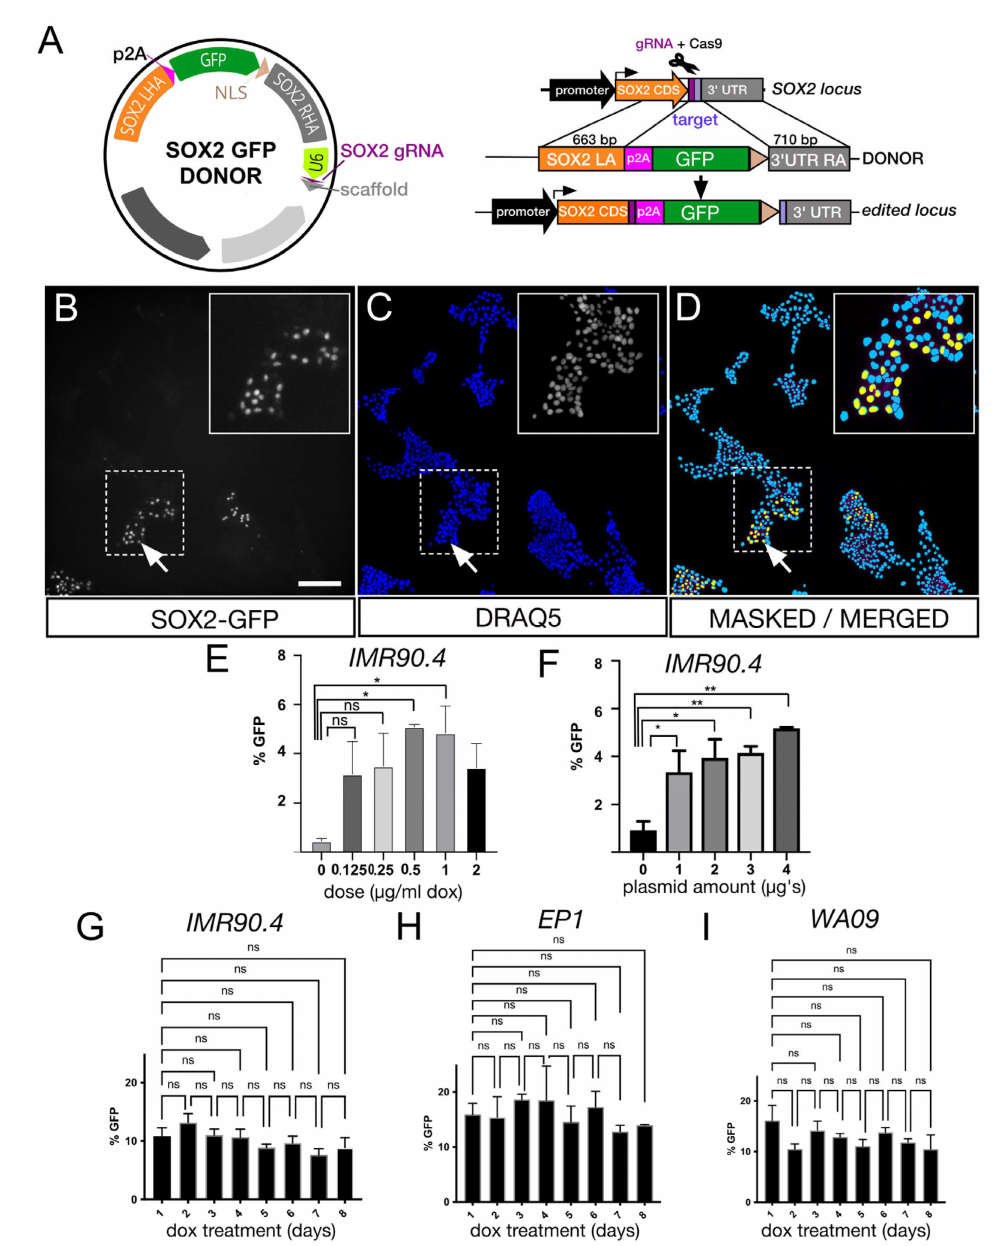
Figure 2. Doxycycline inducible gene targeting at the SOX2 locus. ( A ) A diagram illustrating the design of a hybrid SOX2-GFP donor vector that carries a targeting cassette for the endogenous SOX2 gene and a U6 promoter driving a SOX2 specific guide RNA (left) and an overview of the editing strategy at the SOX2 locus (right). Imaging of SOX2-GFP integrated cells visualized by ( B ) GFP fluorescence and ( C ) DRAQ5 nuclear counterstain fluorescence at 5 days post-transfection. ( D ) GFP+ cells (yellow; arrows) and DRAQ5 labeled nuclei (blue) were identified by automated segmentation and mask generation used for cell counting. ( E ) SOX2-GFP integration efficiency in IMR90.4-HF-iCas9 cells after increasing doses of dox, or ( F ) increasing doses of plasmid for transfection. ( G ) IMR90.4- HF-iCas9, ( H ) EP1.1-HF-iCas9 and ( I ) WA09-HF-iCas9 PSCs following a time course treatment with dox. Each sample was calculated from 25 fields ( n > 3 biological replicates) of view with error bars represented as standard error of the mean (SEM). One-way ANOVA was used to test statistical significance and for multiple comparison tests, a Dunnett’s multiple comparison procedure was used with an α cutoff of 0.05. * p < 0.05, ** p < 0.01, ns = not significant. Scale bar ( B – D ) = 200 µ